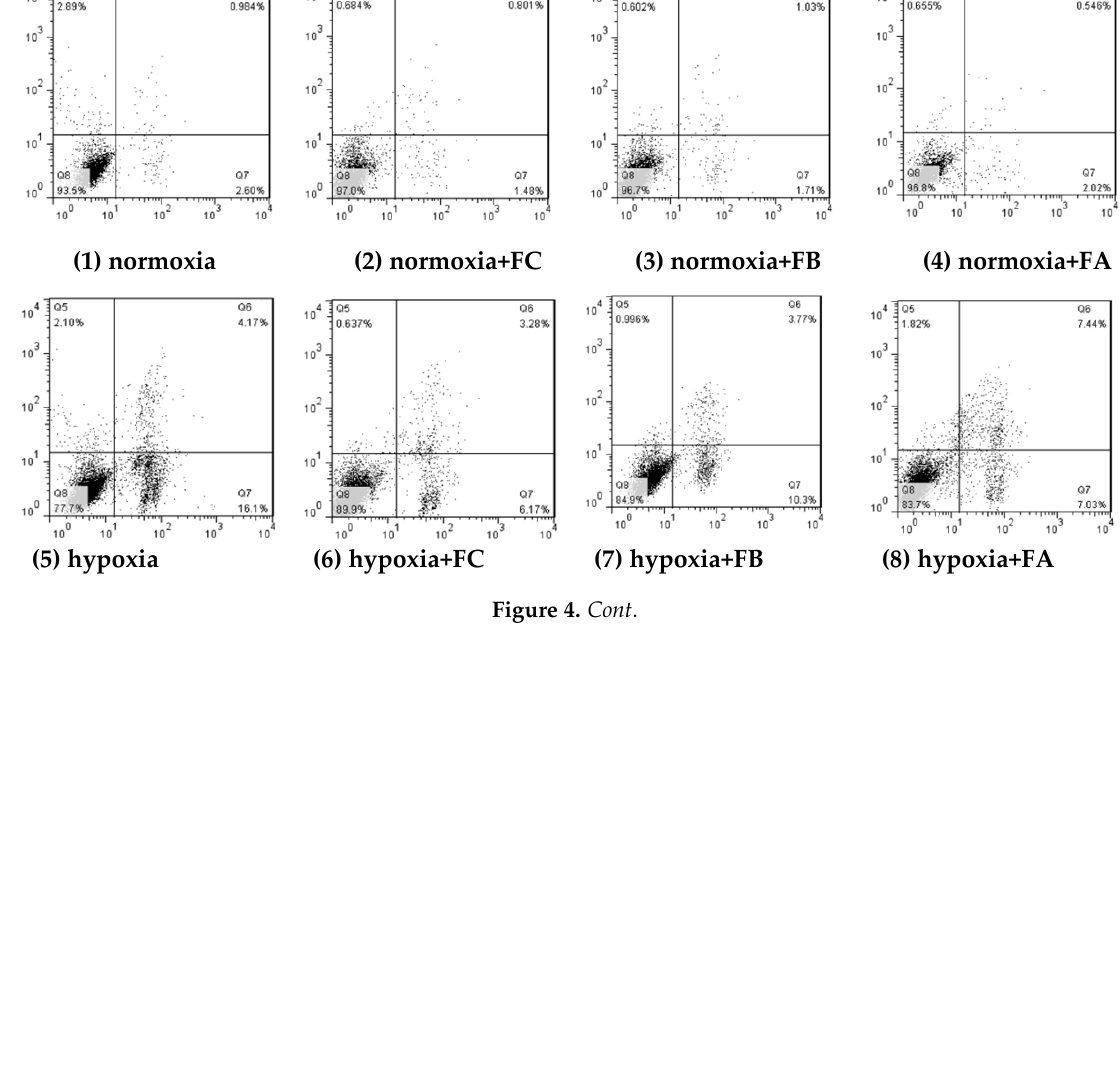
Figure 4. Hypoxia-induced apoptosis and the protective effect of three polysaccharide fractions after 24 h of treatment on PASM cells. Percentages reflect the total apoptotic cells (pre-apoptotic and apoptotic: quadrants two and four combined) pertreatment for means with different letters are significantly different from each other ( p < 0.05). 2.3. Effect of Three Polysaccharide Fractions on Cell Compensation Responses to Acute Hypoxia Considering the molecular identity of the O 2 -sensor in PASMCs, the precise mechanisms that explain how hypoxic condition inhibit the K + channels remain unclear, although several pathways have been proposed. Hypoxia may inhibit K + -channel activity by regulating one or more of the following: reactive oxygen species production, redox status and cell metabolism, and/or oxygen- sensitive molecules that are part of the channel or are closely associated to the channel protein [15]. Interestingly, none of these mechanisms are able to explain all of the data available, so it is likely that there is probably no single unique O 2 -sensing mechanism within the PASM cell. The postulated mechanism of hypoxia on PASM cells was provided in Figure 5. Though it has been known for many years that these stimuli increase cerebral blood flow, defining the mechanisms regulating these responses has been difficult. Upon cell compensation responses mechanism, we also investigated the six response items after three polysaccharide fractions were added to cell incubating system under hypoxia.